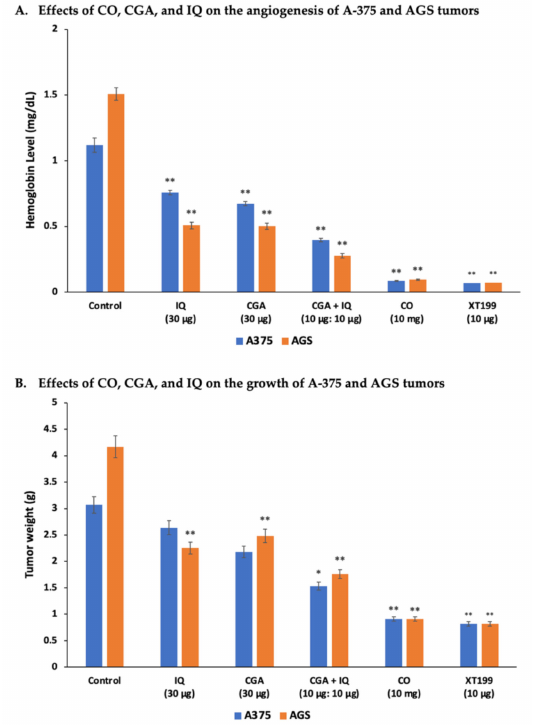
Figure 3. CO, CGA, IQ, and CGA + IQ inhibited angiogenesis and tumor growth of A-375 and AGS cancer cells. ( A ) Hemoglobin level measured from the CAM-implanted tumors after eight days. ( B ) Weight of the A-375 and AGS CAM tumors eight days after implantation and treatment. Data are represented as mean ± SEM ( n = 3). * p < 0.01, ** p < 0.001 versus the control (untreated)